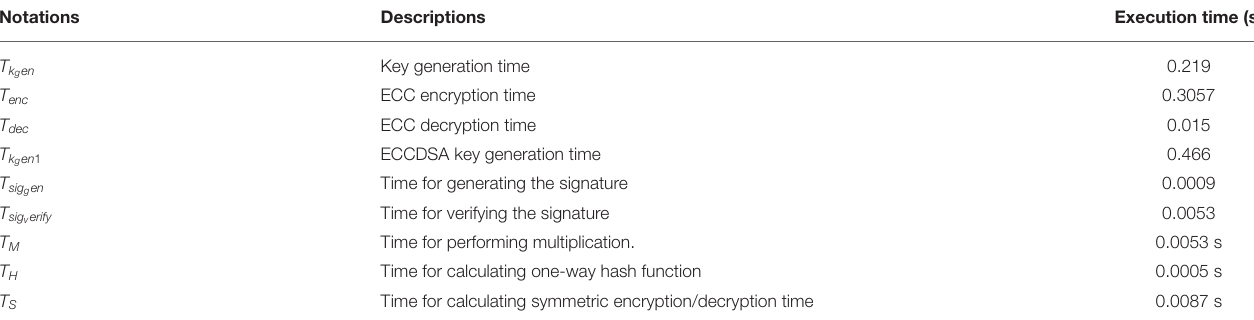
TABLE 2 | Execution time of various cryptographic